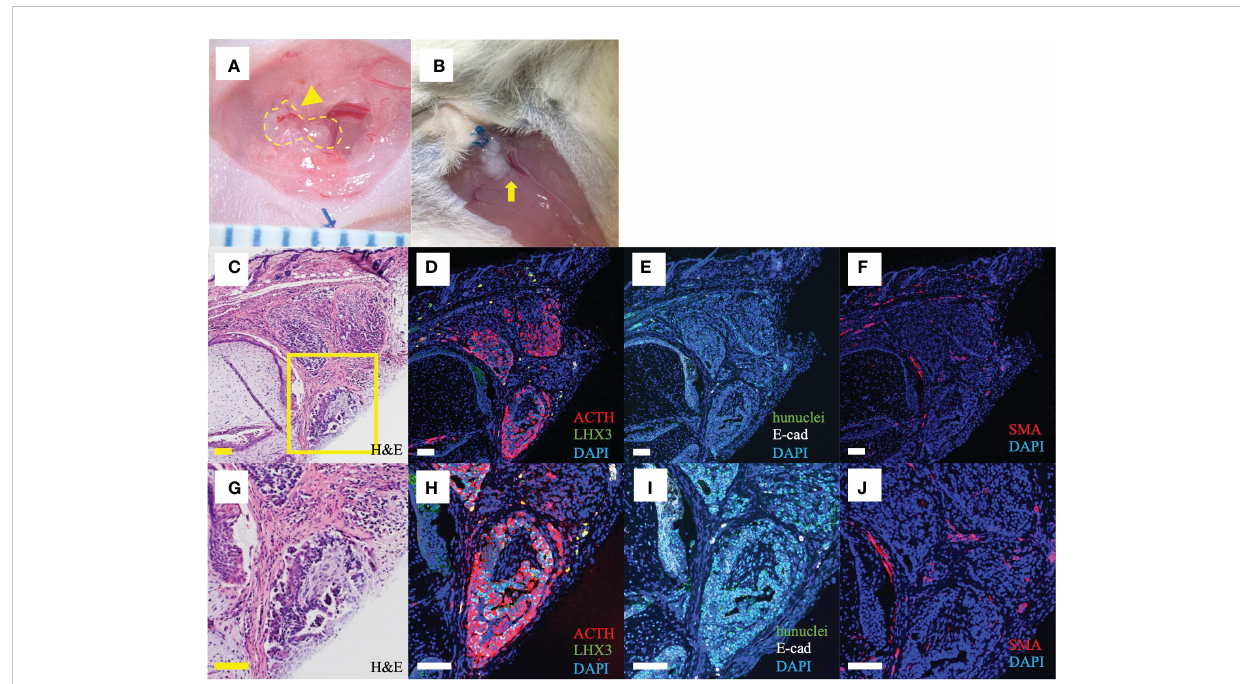
FIGURE 3 Macroscopic and histological fi ndings after ISWAT transplantation (A) Macroscopic appearance, graft site, 4wk after transplantation. Dotted line, grafted POs. Arrowhead, vessel associated with graft. Scale intervals, 1mm. (B) Macroscopic appearance, 21wk after transplantation. Arrow, engrafted POs. (C, G) Skin and subjacent tissue including graft. Several POs are included in the section. Hematoxylin/eosin (H, E) . Yellow box, (D – J) , (D – F, H – J) Immuno fl uorescence photomicrographs, various antigens targeted. Counterstaining with 4,6-diamidine-2 -phenylindole dihydrochloride (DAPI). (D, H) Adrenocorticotropic hormone (ACTH, red) and LIM-homeobox protein (LHX3, green), a pituitary progenitor marker. (E, I) Human nuclei (hunuclei, green) and E-cadherin (E-cad, white), an oral ectoderm marker. (F, J) Smooth muscle actin (SMA, red), a vessel-wall marker. Scale bars uniformly 100 m